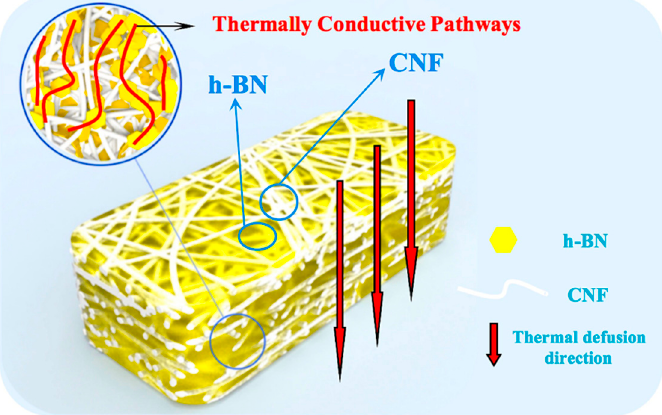
Figure 4. The proposed thermal defusion mechanism of h-BN/CNF aerogel perfusion film.